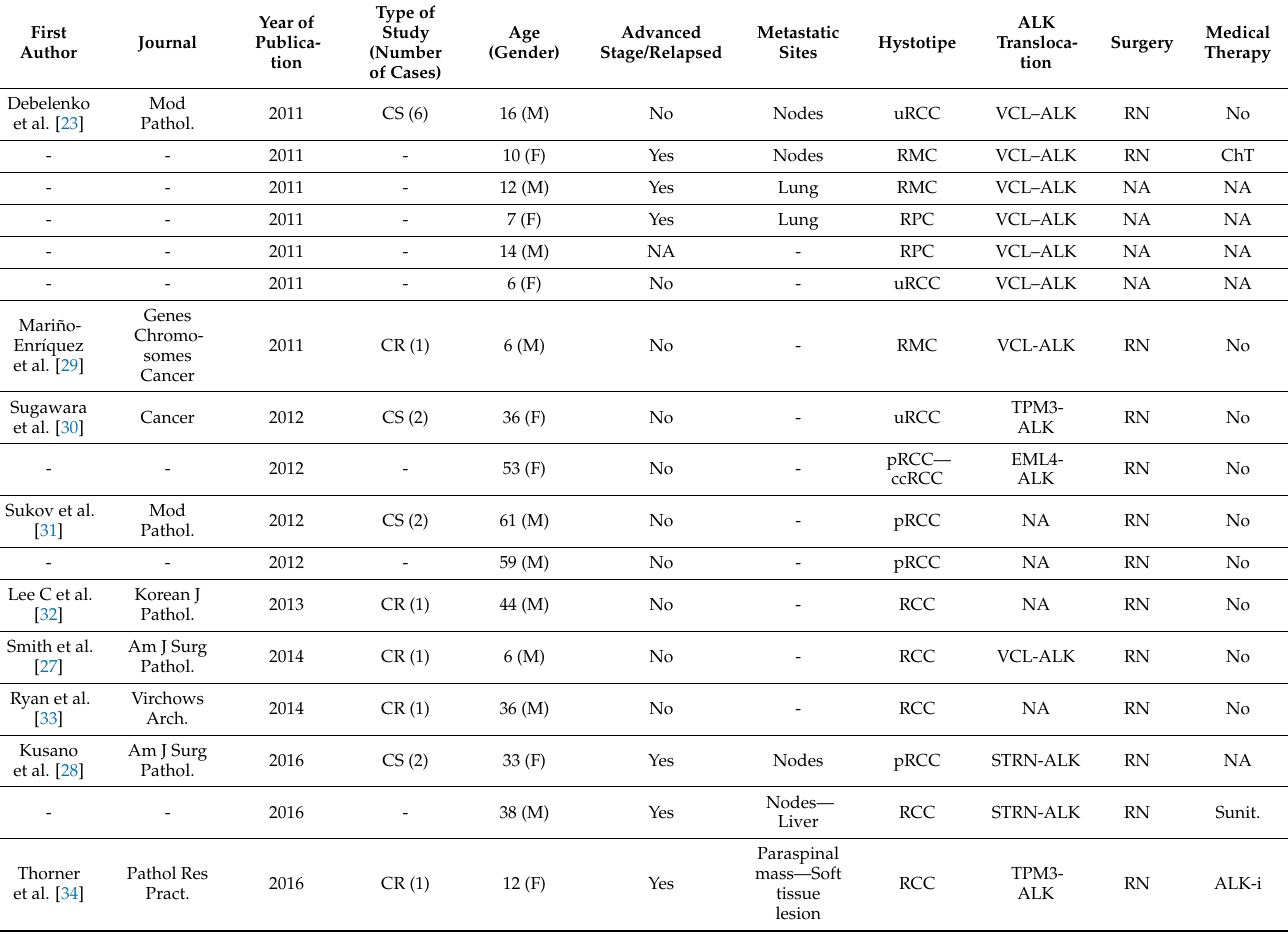
Figure 4. Number of publications on ALK-RCC based on the year of publication. Table 3. Previously published cases of ALK ‐ RCC.